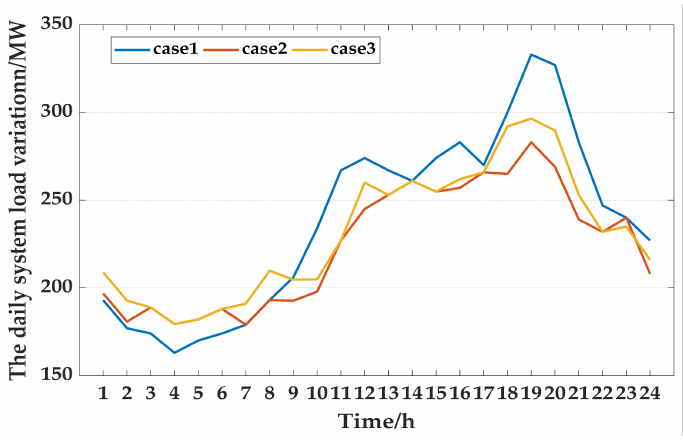
Figure 12. Outputs of G1 in three cases.